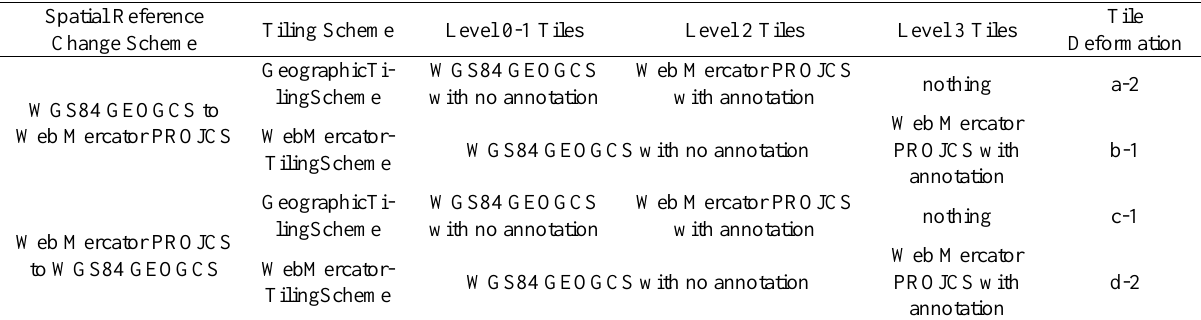
Table 1. Design under the same data source with different spatial references